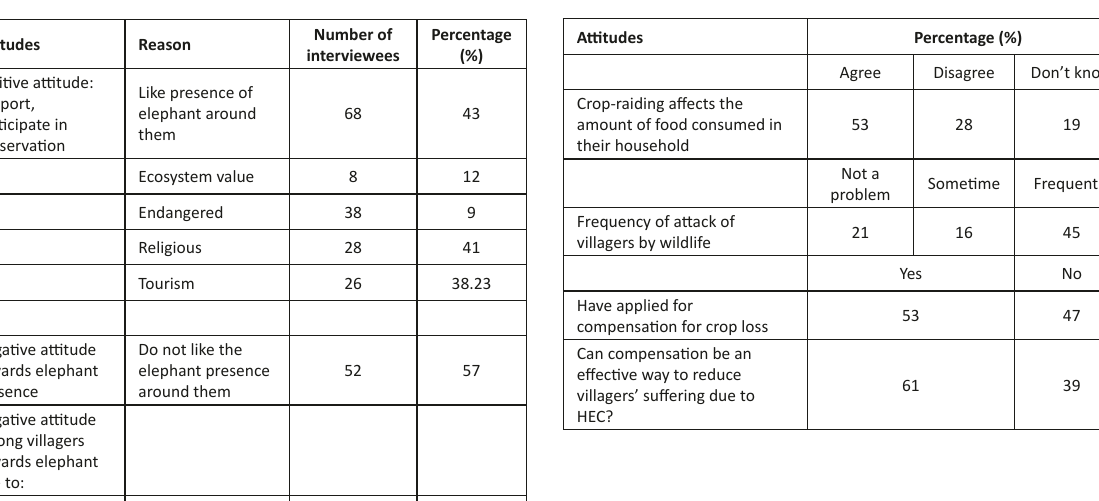
Table 2. Attitudes of local communities towards compensation schemesforHuman Elephant Conflict